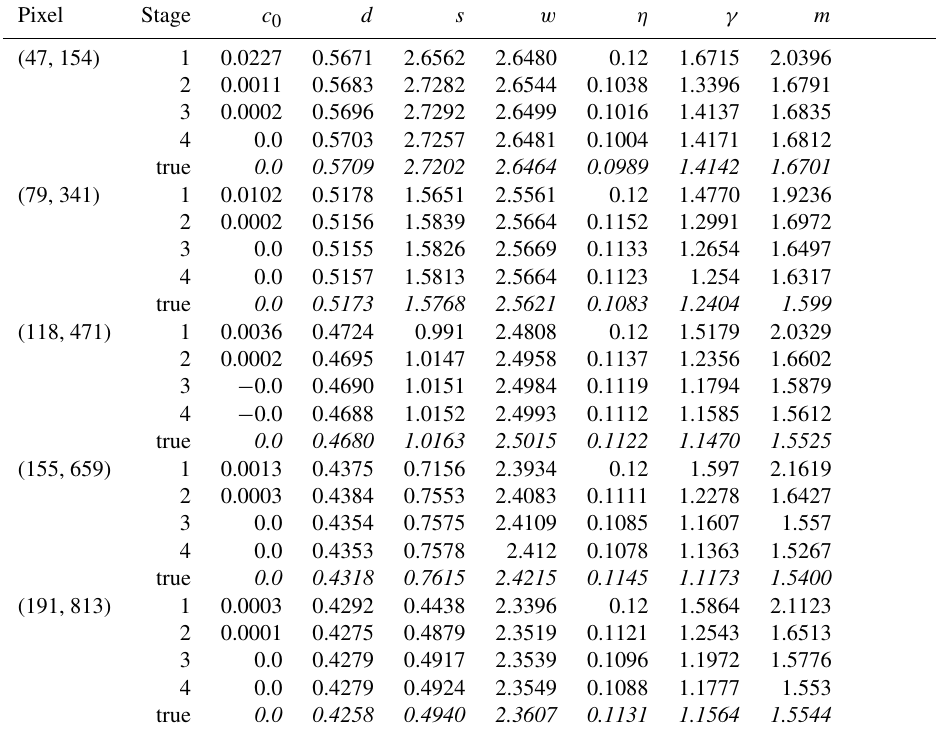
Table 1. The convergence of the ISRF parameter iteration is shown by listing the determined ISRF parameters at the end of four stages. The simulations are performed on five synthetic ISRFs representative for the determined TROPOMI-SWIR ISRF, equally spaced at positions on the SWIR detector from top left to bottom right. The synthetic data are generated without noise. The shape parameters for the true ISRF are listed in